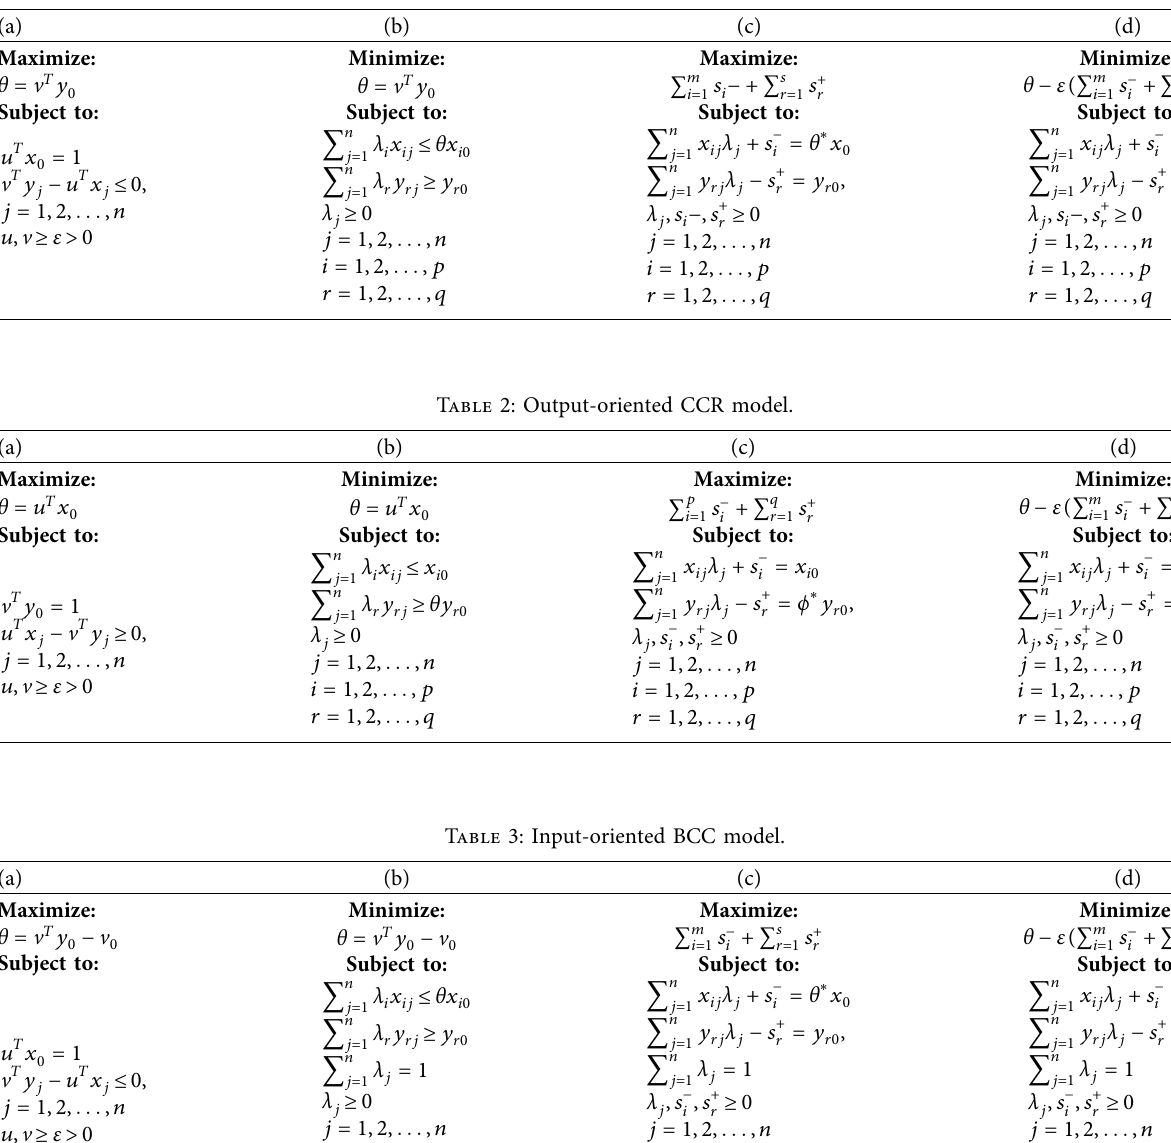
Table 1: Input-oriented CCR model.